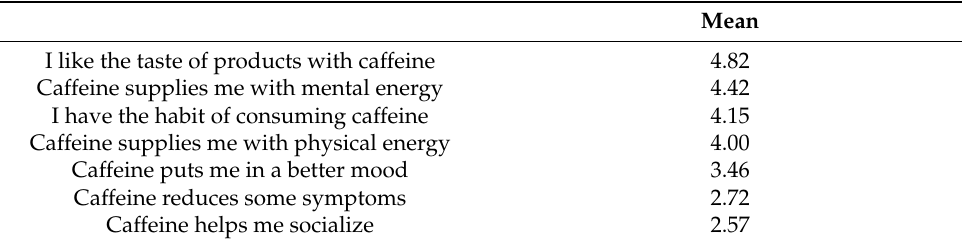
Table 4. Motives of caffeine